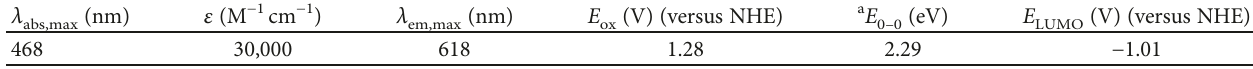
Table 1: Experimental data of electrochemical and spectroscopic properties of the CL1 dye.